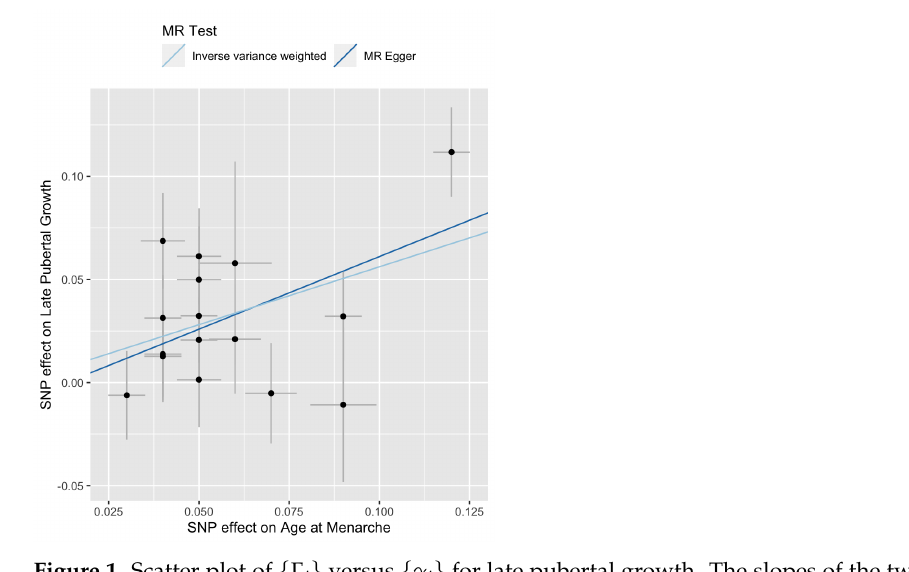
Figure 1. Scatter plot of { Γ i } versus { γ i } for late pubertal growth. The slopes of the two lines are the MR estimates of the causal effect. The right-most point corresponds to SNP rs7759938 in the LIN28B